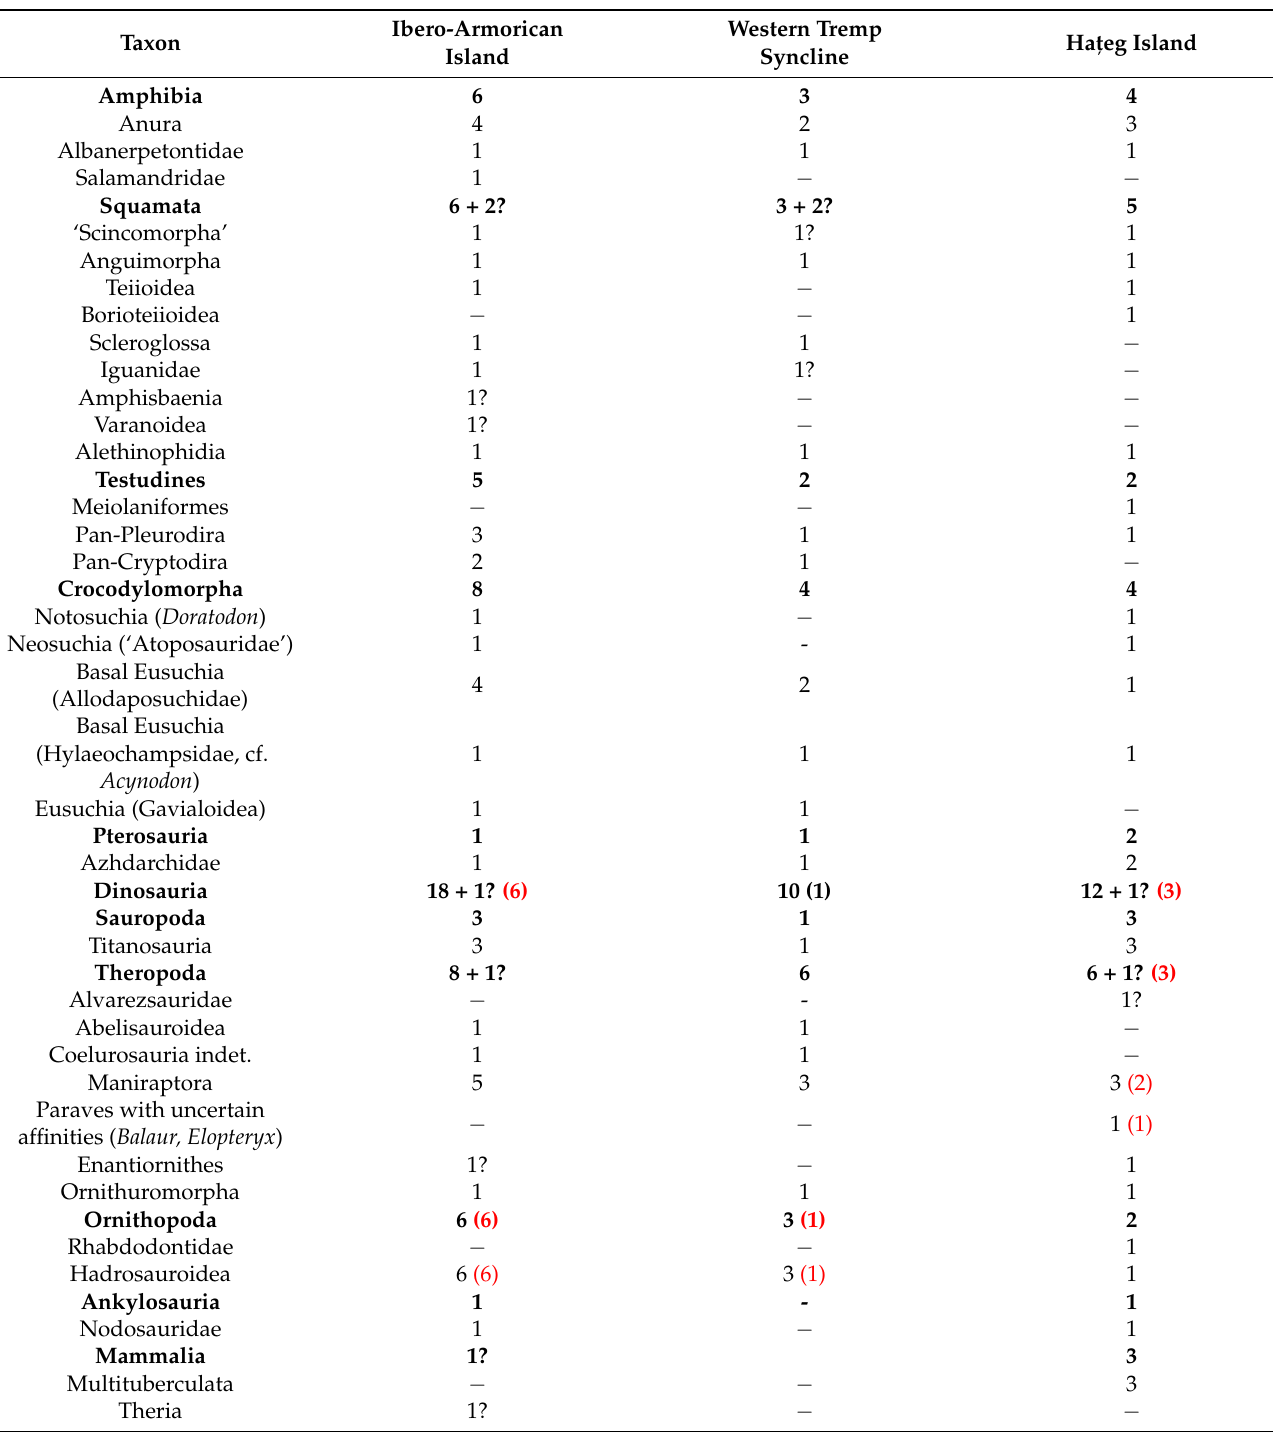
Table 1. Number of tetrapod taxa present on the Ibero-Armorican and Hat numbers mark possible additional